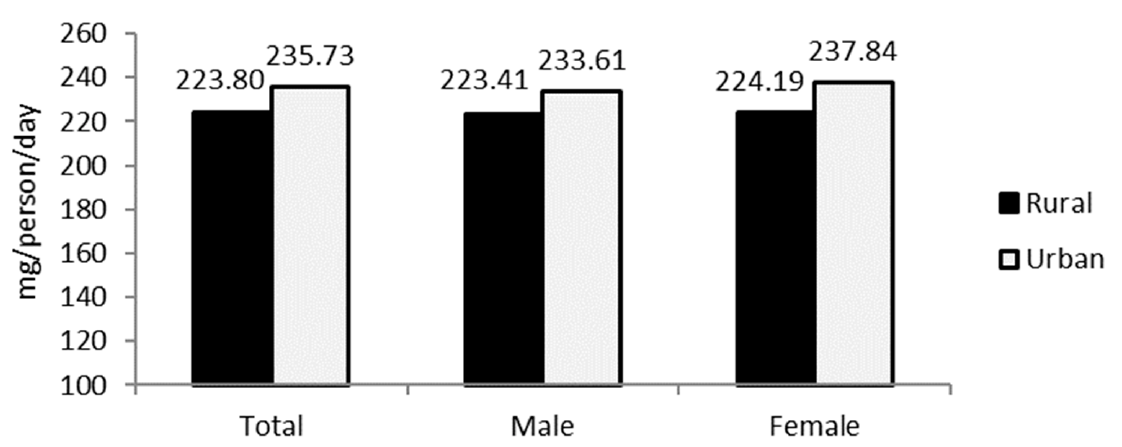
Figure 1. Plant sterols intake in the groups of male and female respondents from rural and urban Bogor area. In this study, cereals were the main source of plant sterols for all respondents (37.46% and 37.21% in the case of rural and urban respondents, respectively), followed by legumes and legume products (24.41% and 23.59%), and snacks foods (15.33% and 15.42%). The calculated plant sterols intake from each of the food groups by respondents representing rural and urban population of Bogor is depicted in Table 4. The percentage contribution of the plant sterols from each of the consumed food groups to the overall plant sterols intake by rural and urban respondents is additionally shown in Tables S4 and S5, respectively. Table 4. The contribution of each of the food groups to plant sterol intake in the rural and urban population